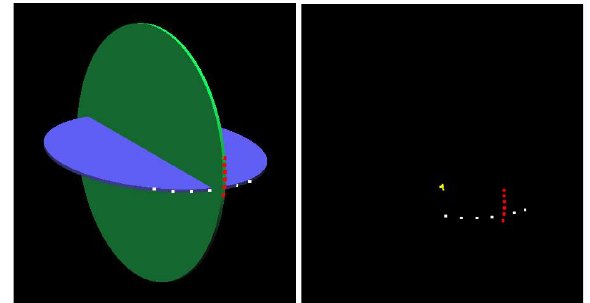
Figure 11. The calibration of the motorized camera mount. The sub-image locations before the mount calibration are presented in the left image. In the right image, the yellow dots represent the sub-image locations after the mount calibration.